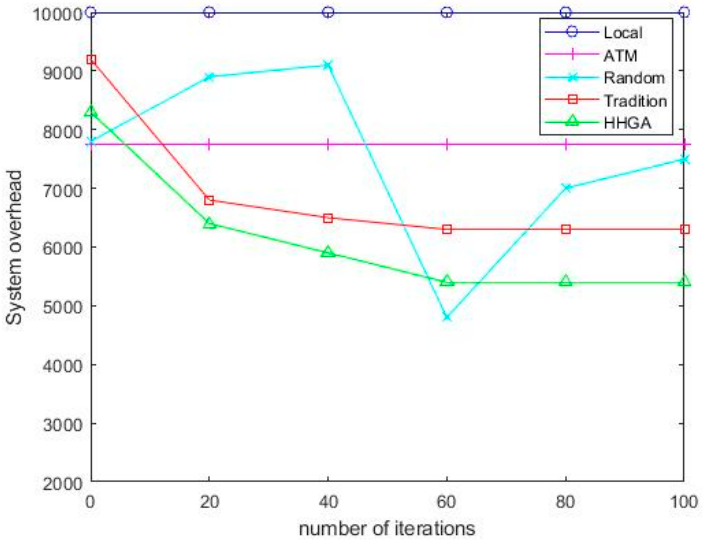
Figure 4. Comparison of offloading schemes.